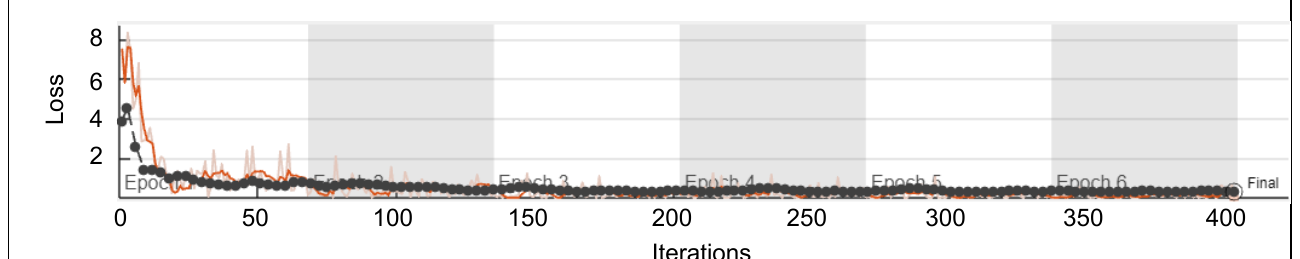
Figure 17. Accuracy versus iteration graph for Iris image.